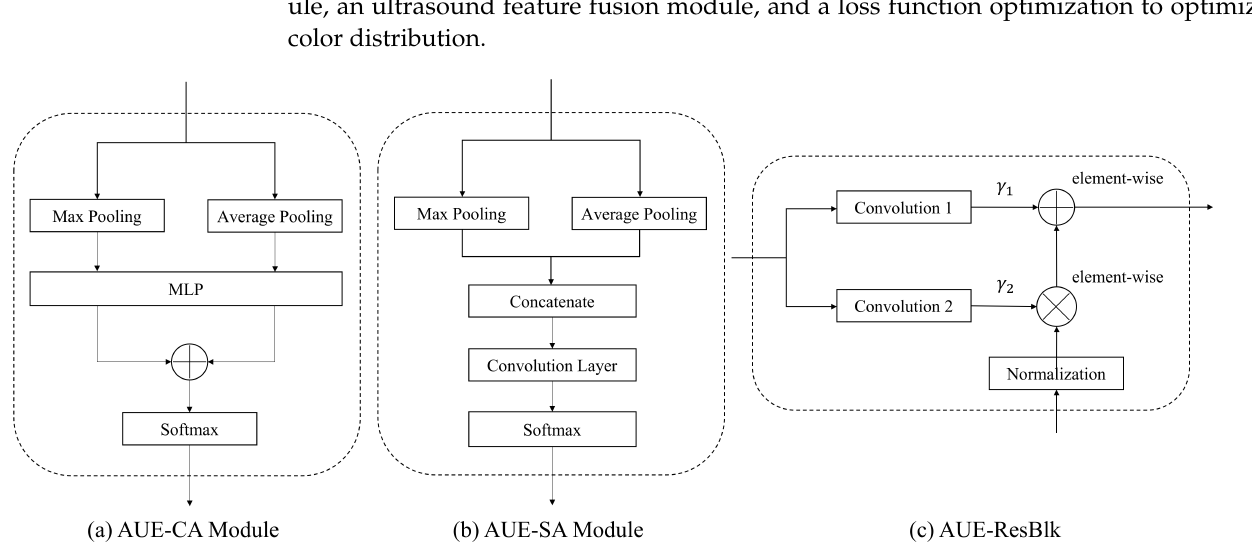
Figure 4. Submodules of our AUE-net. ( a ) is used to create a color attention map for elastography image color. ( b ) helps to locate nodule in elastography image. ( c ) helps making full use of feature information extracted before.